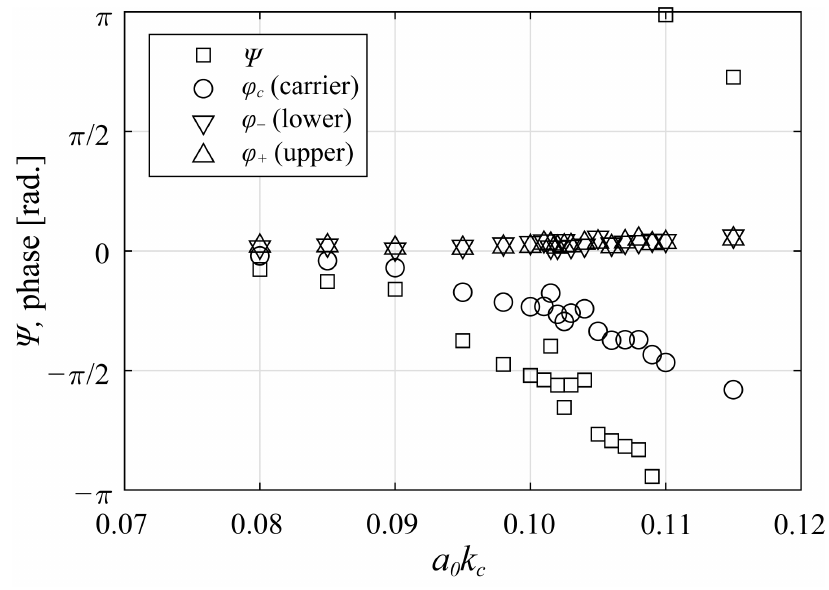
Figure 17. Variations of Ψ . and the carrier, lower-sideband, and upper-sideband phases at the time of maximum crest height against initial wave steepness a 0 k c